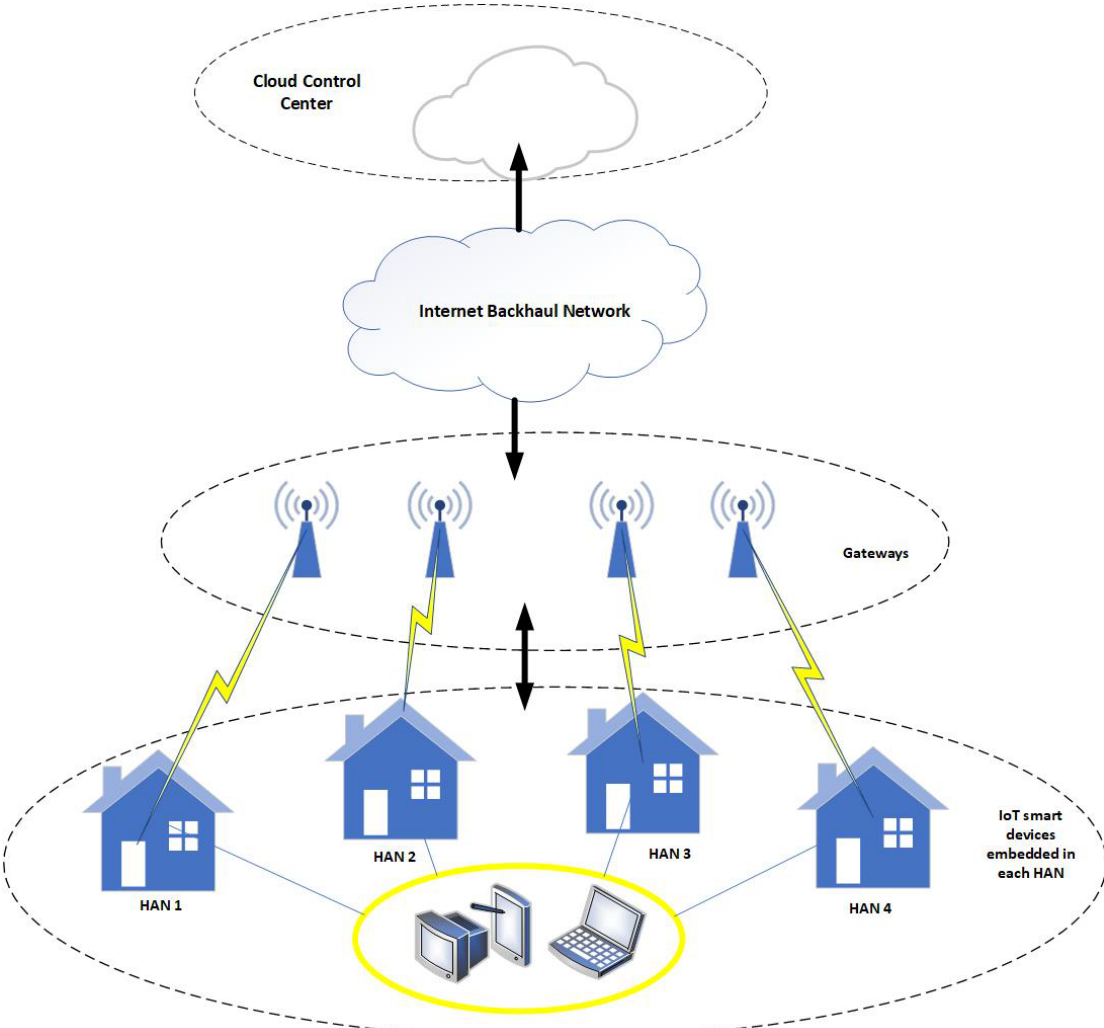
Figure 4. Traditional cloud